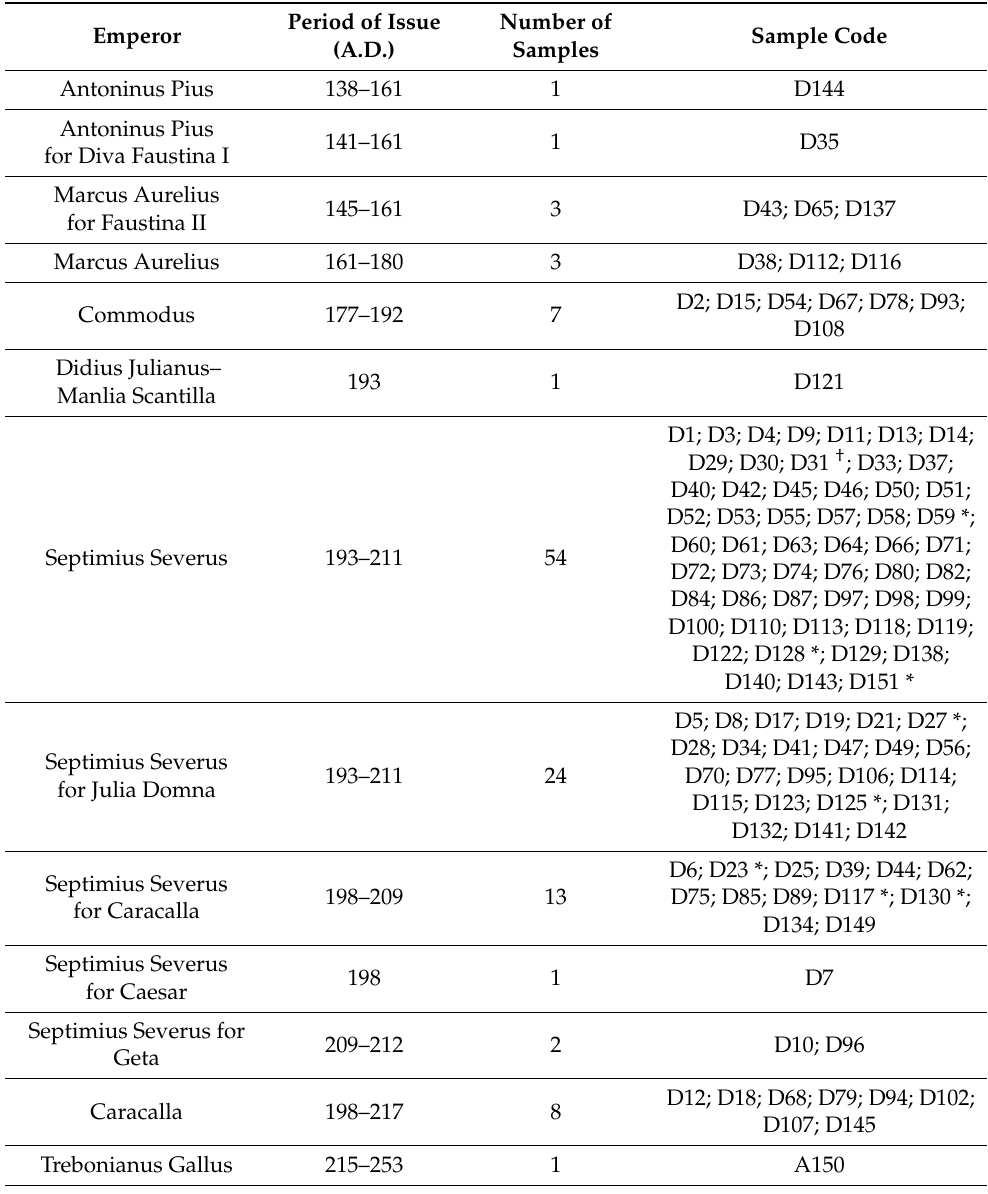
Table 1. List of coins under study. Each coin is associated with a code where A = antoninianus, D = denarius, followed by a progressive number from 1 to 160. Coins marked with a star ( * ) are sampled for ICP-AES and ICP-MS analyses, while coins marked with a cross ( † ) are those analysed with